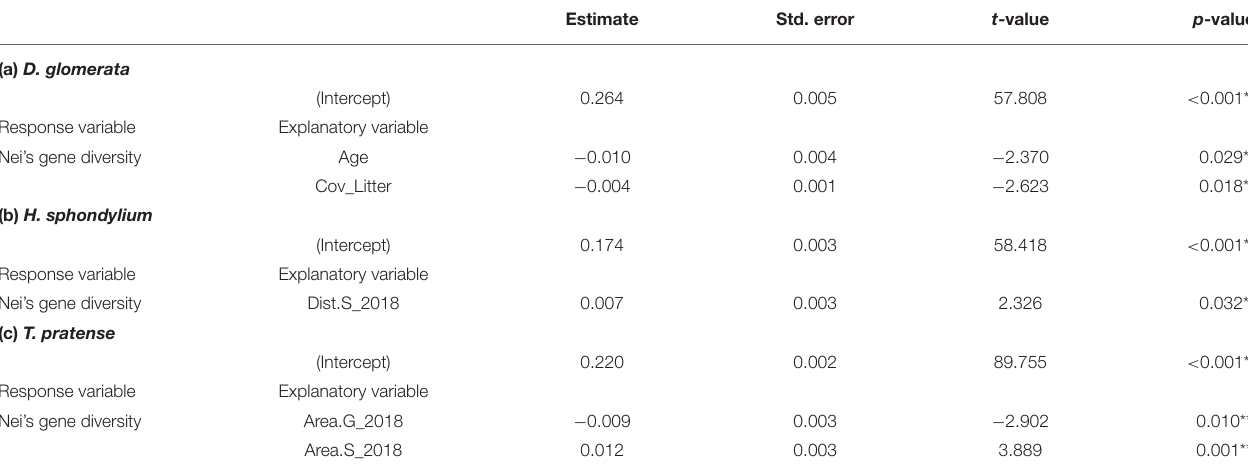
TABLE 4 | Linear models explaining genetic diversity of D. glomerata (a) , H. sphondylium (b) , and T. pratense (c) .